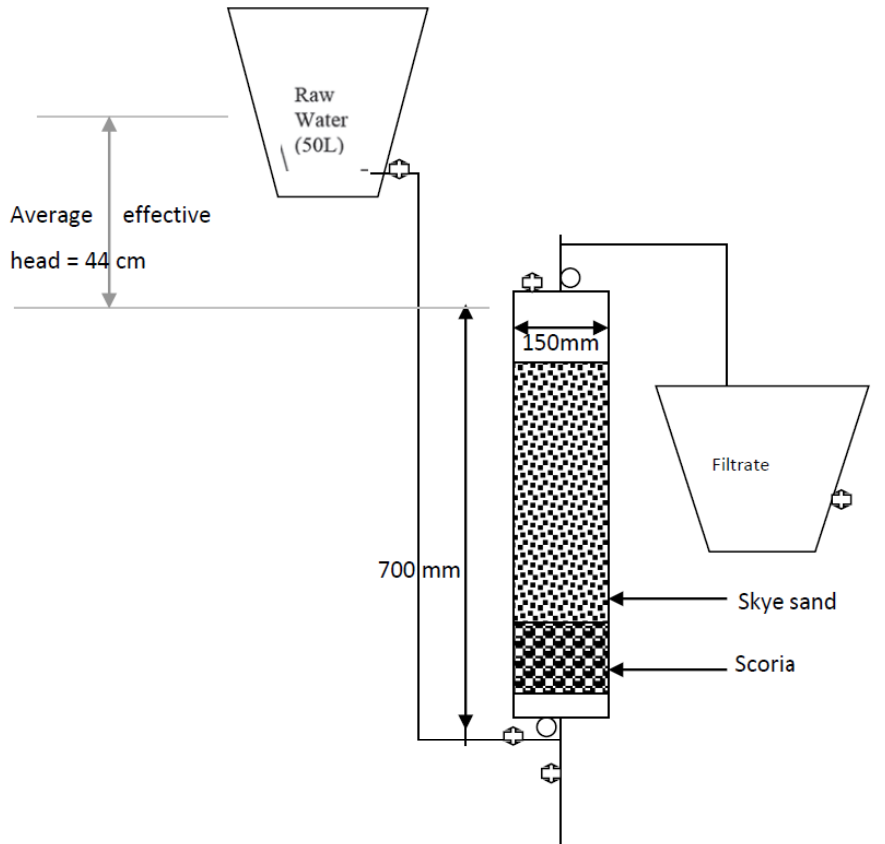
Figure 2. Schematic diagram of the prototype filter with Skye sand.